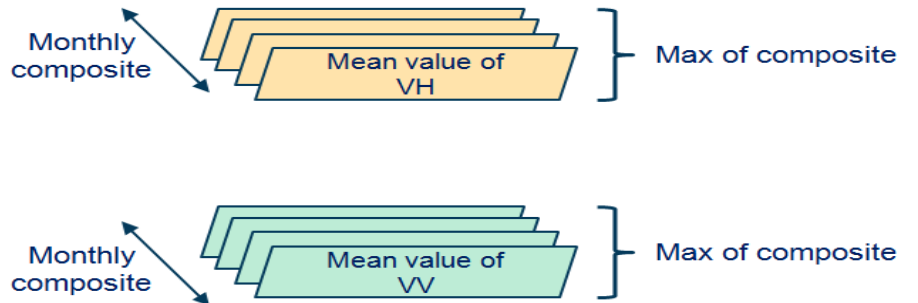
Figure 9. Monthly composite flooding maps.